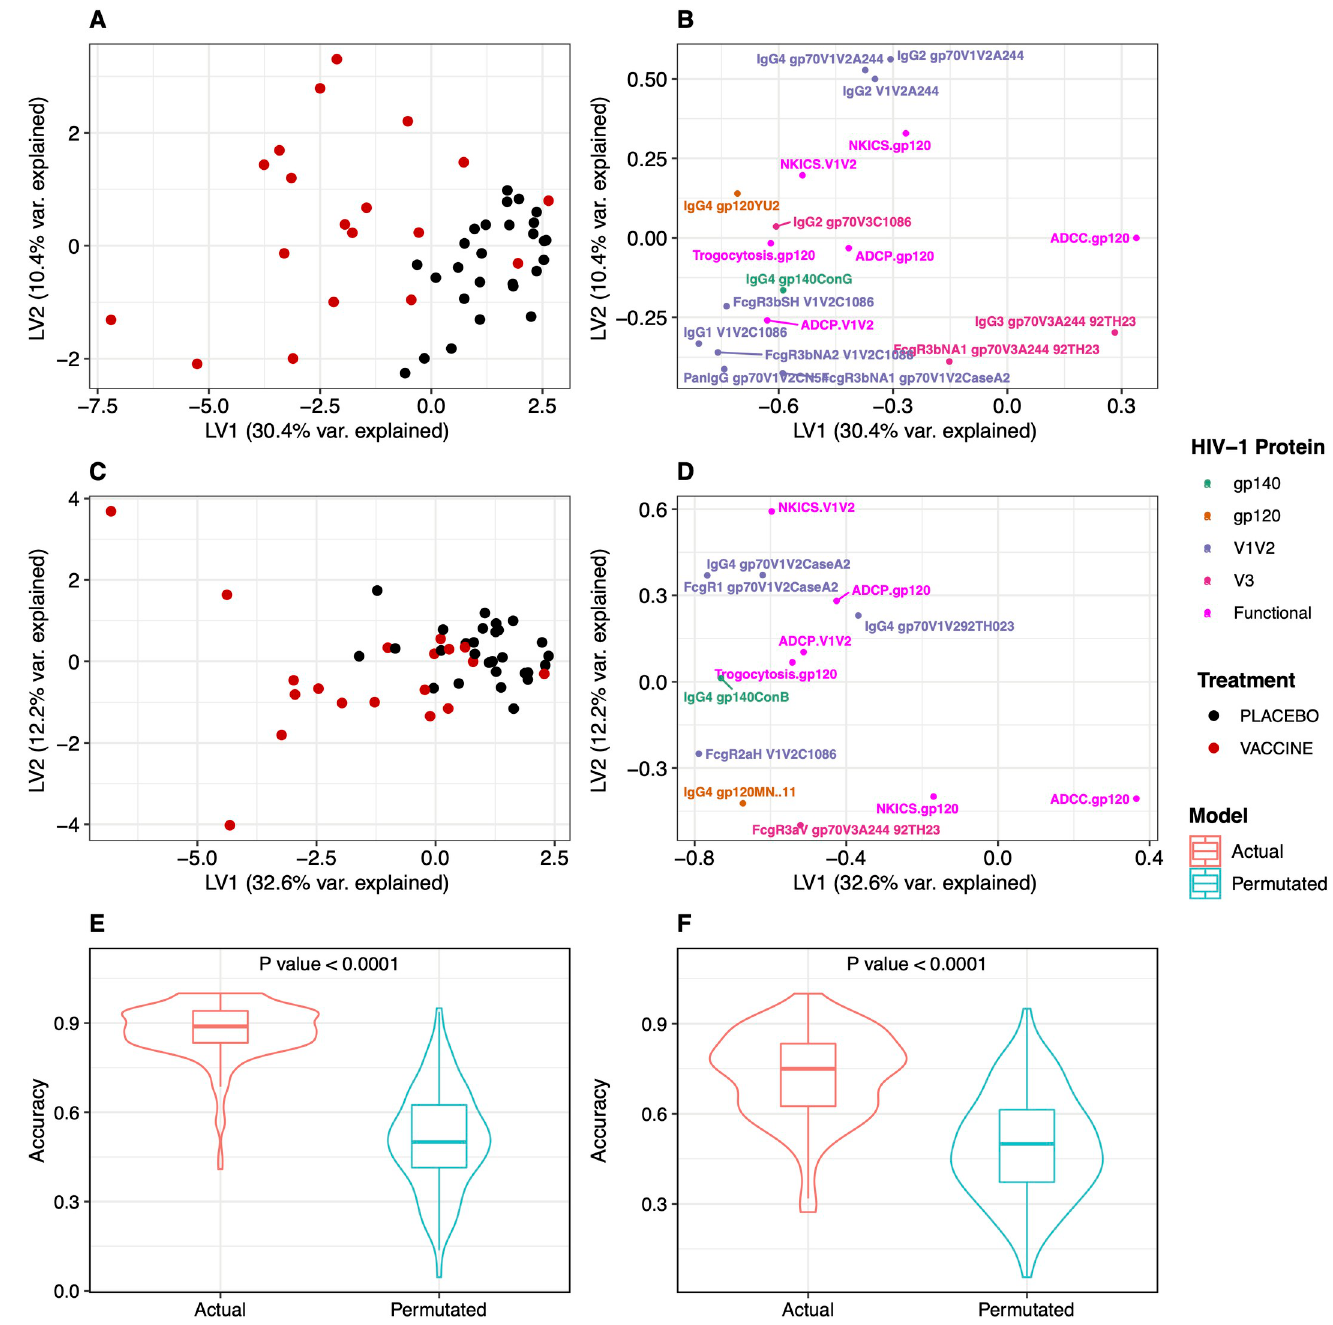
Fig 6. A combination of antibody binding features and Fc effector functions defined a vaccine profile. PLSDA models are shown for year 1 (A, B) and year 3 (C, D) with PLSDA scores on the left and loadings on the right. (E, F) Performance of PLSDA classification models compared to group permutated models. Cross-validation confirmed that PLSDA models were significantly better than null models generated by permuting treatment groups.